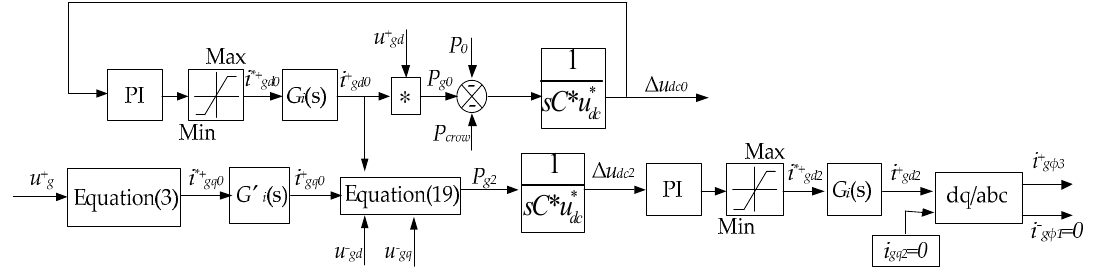
Figure 5. Generation mechanism of positive-sequence triple-frequency